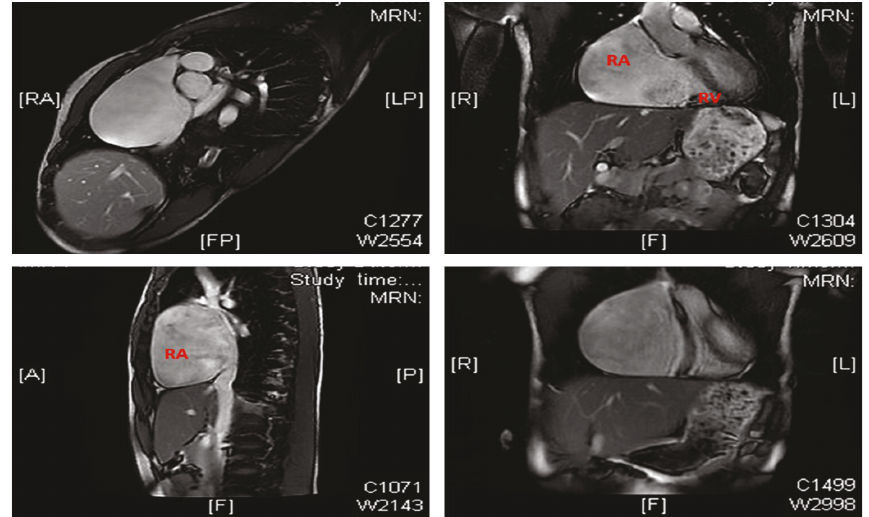
Figure 3: Cardiovascular magnetic resonance (CMR) that con fi rmed the dilation of the right atrium without congenital heart disease.